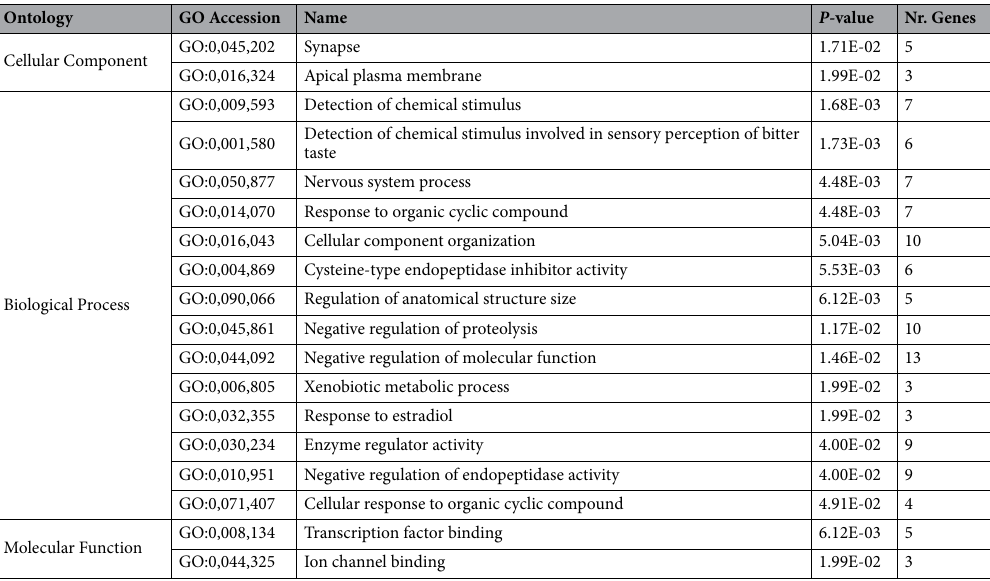
Ontology GO Accession Name P